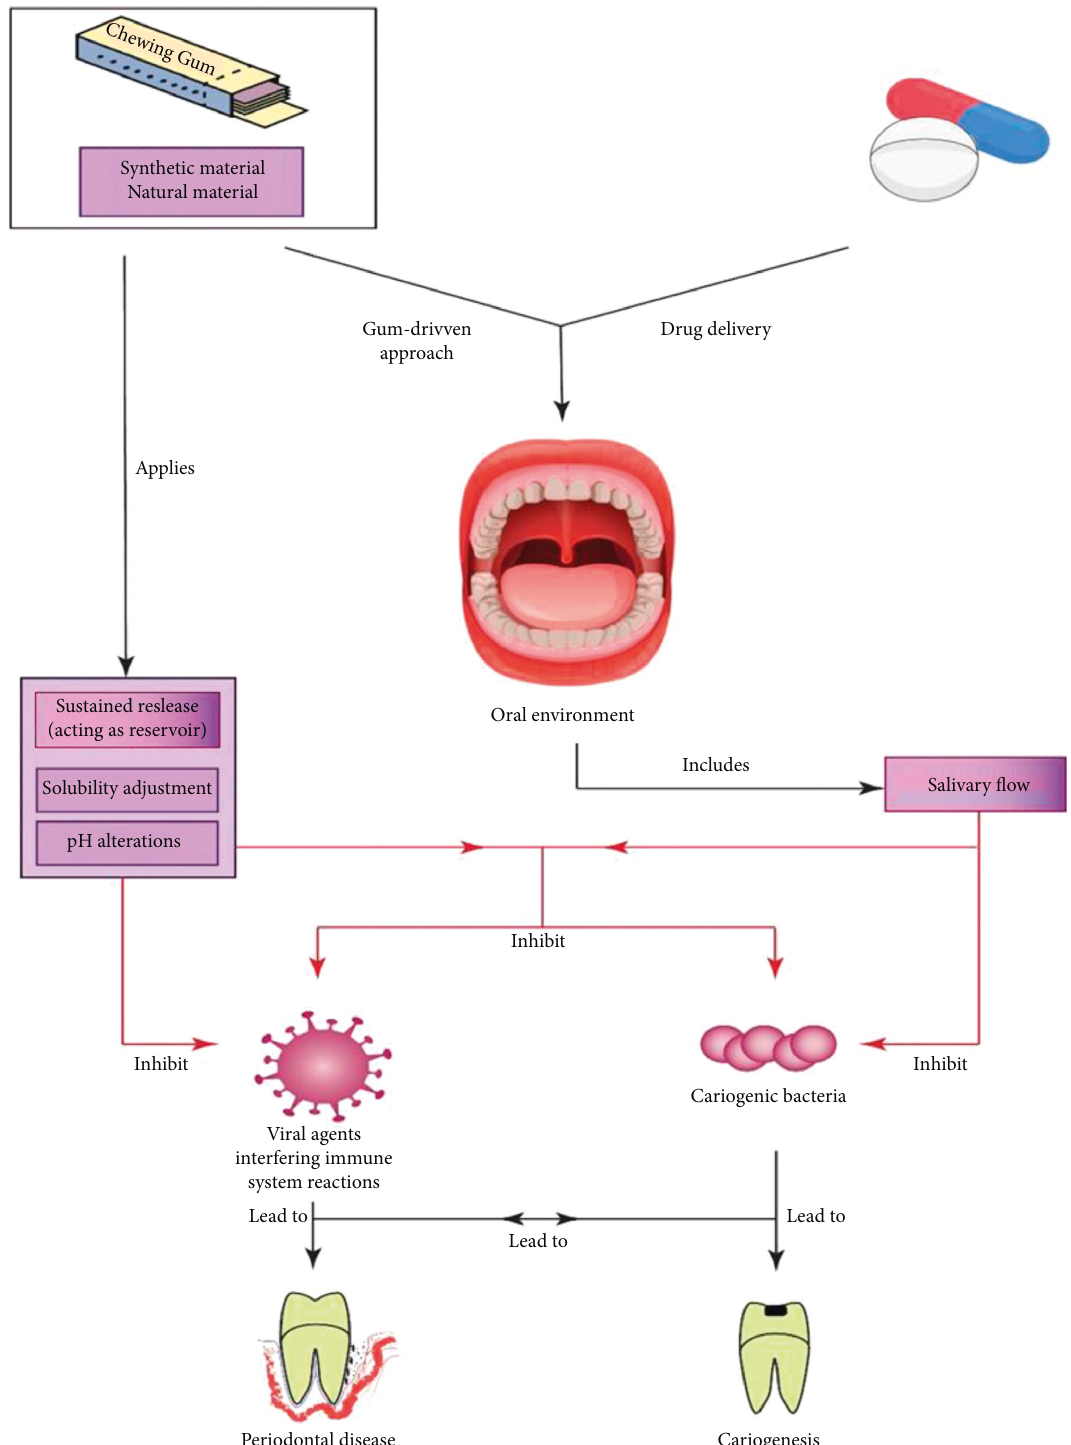
Figure 2: Schematic diagram of the gum drug delivery approach and factors affecting